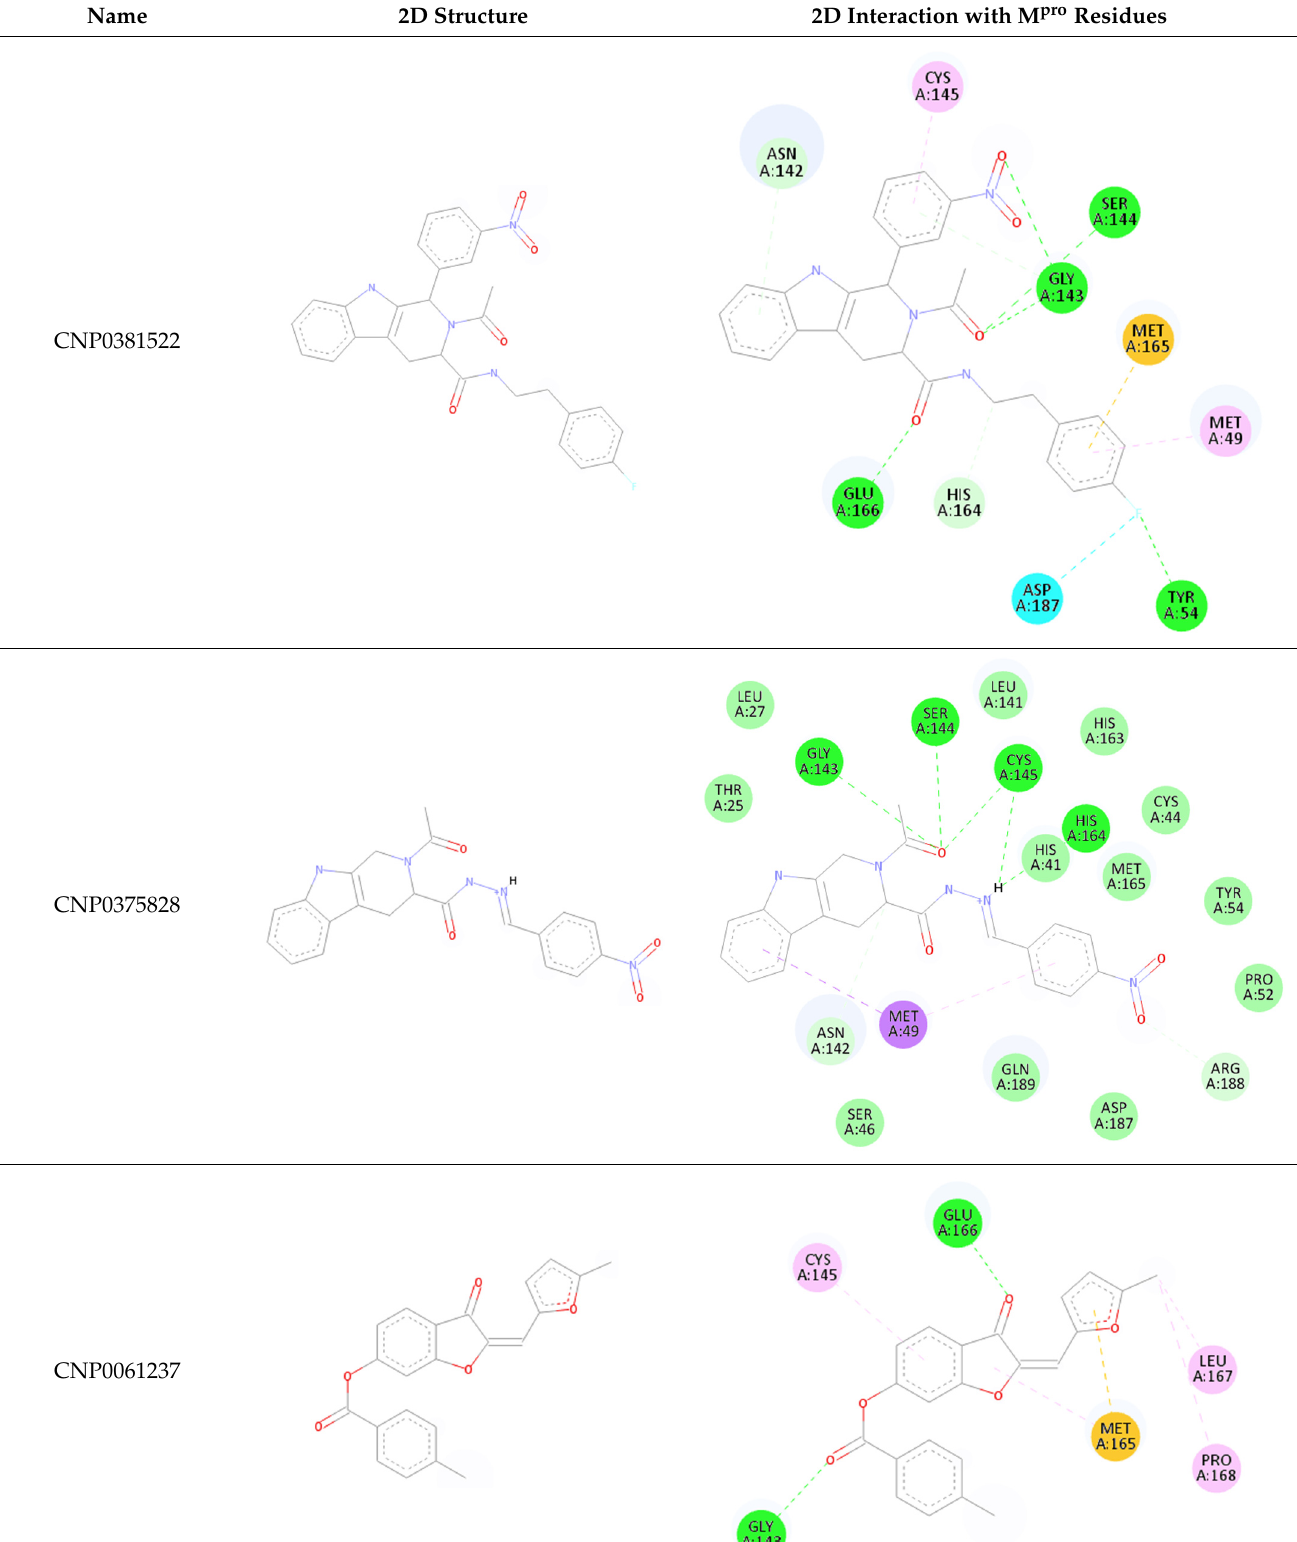
Table 5. Schematics of the 2D interactions between the four in vitro validated ligands and 6LU7 M pro structure.